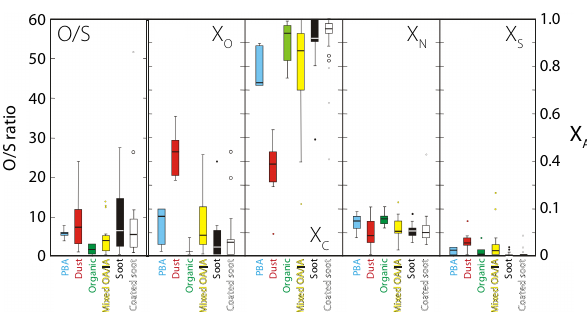
Fig. 3. Characteristic ratios of major elements measured with NanoSIMS used for chemical separation of different particle types for upwind and interstitial aerosol. Boxes indicate the 25–75 per- centile ranges. Whiskers indicate the range until the last value that falls within the median ± 2 σ range. Large and small circles are out- liers and lie outside ± 2 σ sigma and ± 3 σ sigma range respectively. The O/S ratio is shown on the left-hand axis, while the molar ratios of O, C, N and S ( X A ) are shown on the right-hand axis. PBA = primary biological aerosol, OA = organic aerosol, IA = inorganic